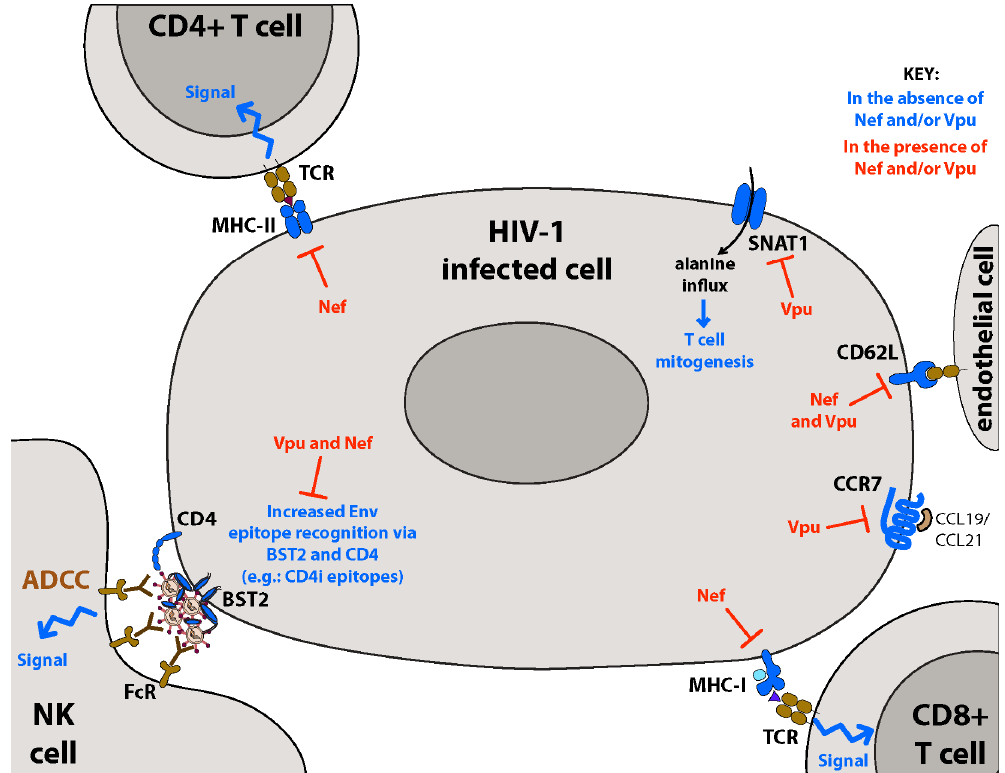
Figure 5. Remodeling of the plasma membrane by HIV ‐ 1 Nef and Vpu modulates immunometabolism and adaptive immunity. HIV ‐ 1 Nef and Vpu proteins work in concert to alter the expression of factors important for adaptive immune responses and optimal immunometabolic function, contributing to viral persistence during the later stages of HIV ‐ 1 acute infection. Downregulation of MHC ‐ I on infected cells by Nef prevents their recognition and clearance by cytotoxic T lymphocyte (CTLs). Decreased surface expression of MHC ‐ II on infected antigen ‐ presenting cells (APCs) by Nef prevents optimal initiation of adaptive immune responses. Downregulation of both CD4 and BST2 by Nef and Vpu prevents the accumulation of CD4 ‐ induced (CD4i) gp120 epitopes at the cell surface, and therefore hampers anti ‐ HIV antibody ‐ dependent cell ‐ mediated cytotoxicity (ADCC) responses. Reduction of sodium ‐ coupled neutral amino acid transporter (SNAT)1 surface expression by Vpu reduces the intracellular alanine pool in infected CD4+ T cells, resulting in their decreased mitogenic capacity in response to TCR ‐ activating stimuli. Downregulation of CD62L and CCR7 on infected cells may inhibit their trafficking to lymphoid structures, further decreasing the initiation of anti ‐ HIV adaptive responses.